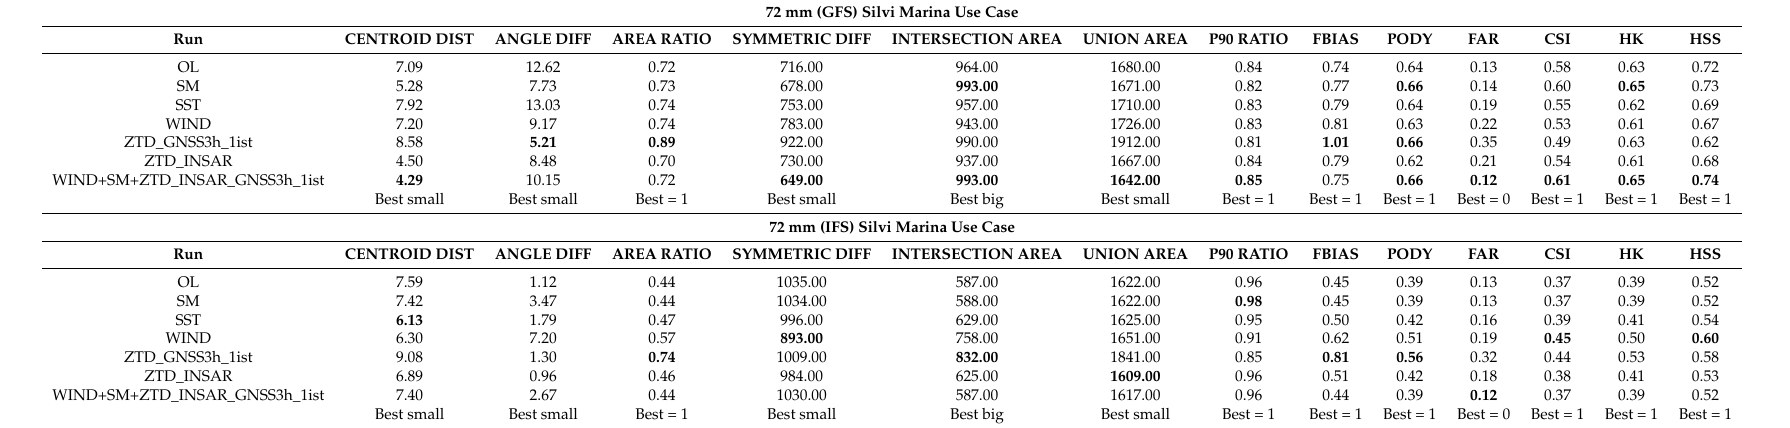
Table A9. Spatial and statistical indices calculated through MODE (72 mm rainfall depth threshold) to evaluate the sensitivity forecasts (driven by GFS and IFS respectively) with respect to the Open Loop run for the time interval 00UTC 15/11/2017–00UTC 16/11/2017. The best performance for each score is highlighted in